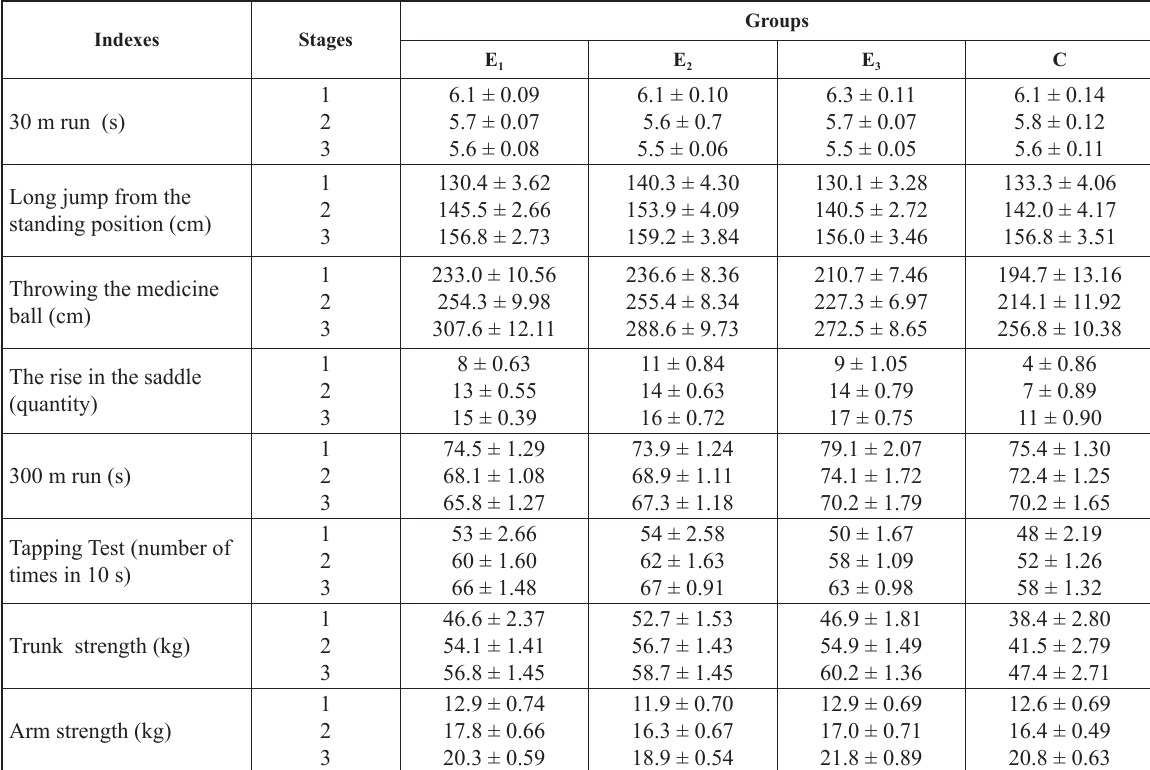
Table 2. Changes of indexes of general physical fitness (X ±